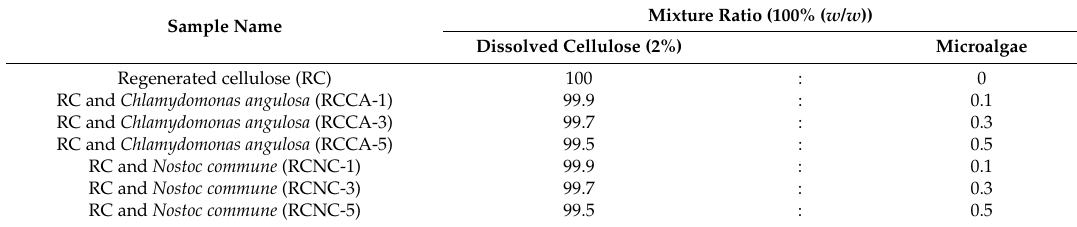
Table 1. Manufacture of composites according to the mixture ratio of cellulose and